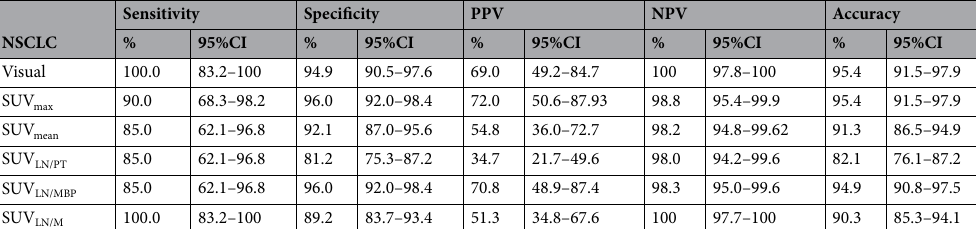
Table 3. Diagnostic performances of the SUV parameters at 18 F-Alfatide PET/CT in patients with NSCLC.